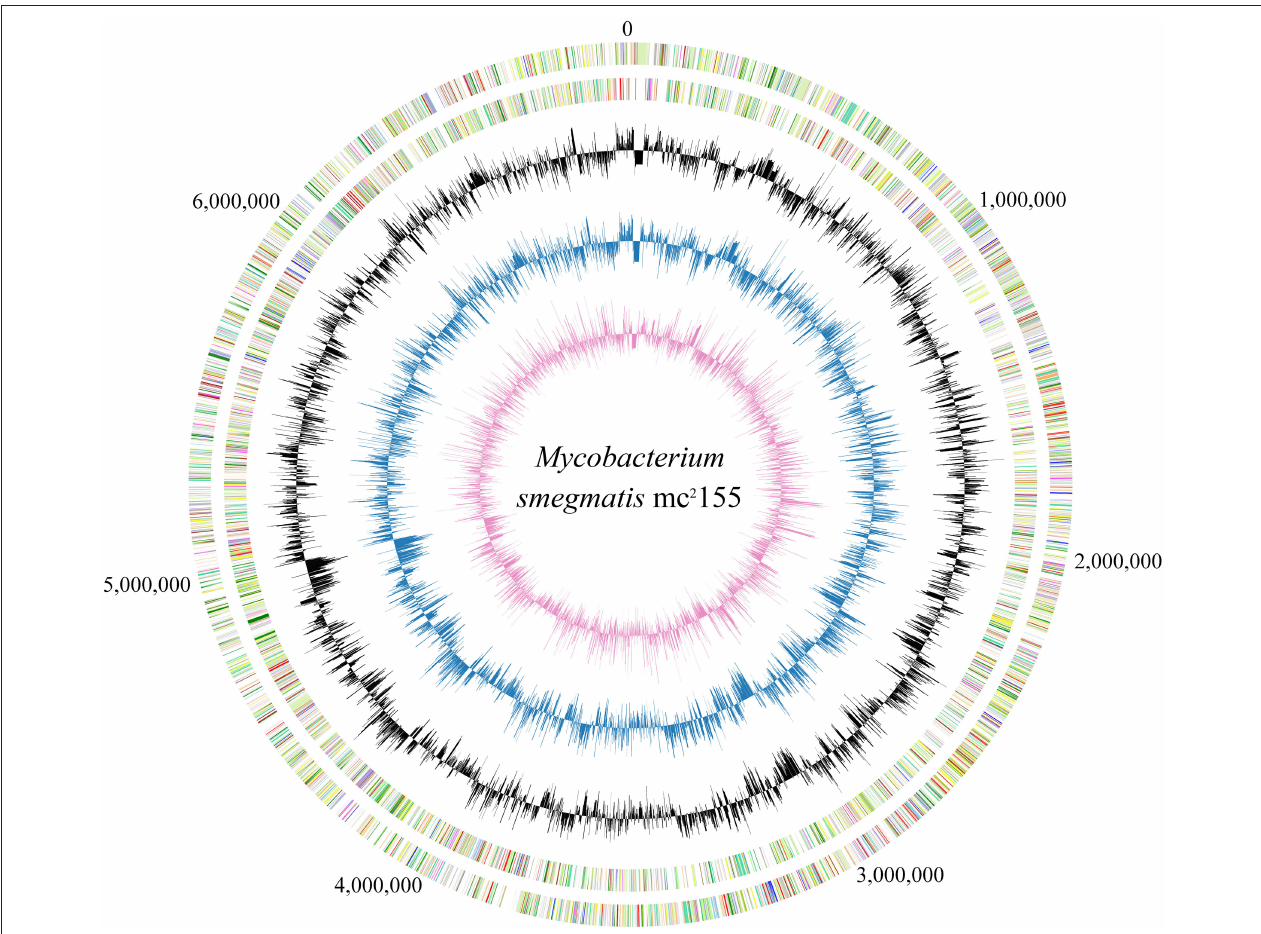
FIGURE 1 | Circular map of M. smegmatis mc 2 155 genome and the corresponding transcriptome. Numbers outside circle show the genome coordinate. Moving inward, the subsequent two rings show CDSs in forward and reverse strands, respectively, with colors representing different COG categories. The inner three rings were colored in black, blue and purple representing the transcriptome maps at 16, 26, and 39h, respectively; the uneven lines above and below the middle circle lines represent the expression level greater or lower than